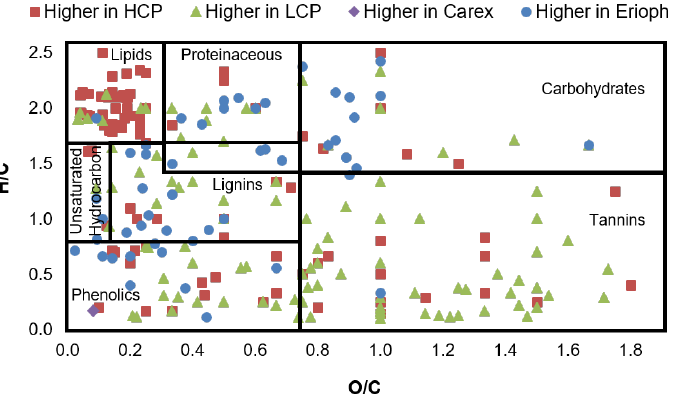
Figure 4. van Krevelen plot for molecular formulas assigned to differentially abundant HQFs due to polygon type or vegetation.